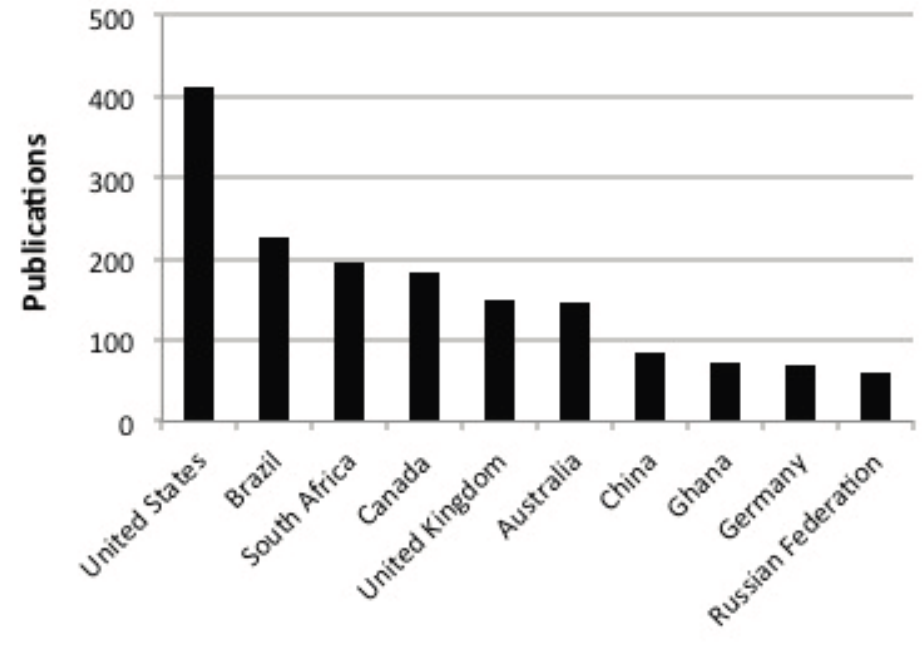
Figure 2. A simple bibliometric analysis using Scopus reveals that Ghanaian researchers are amongst the most prolific worldwide. On 19 March (2015), the term “gold mining” was searched resulting in 2531 papers. Research hailing from Ghana was in the top 10 of all